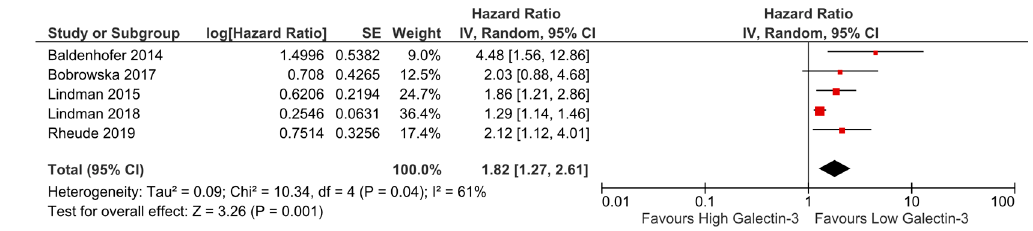
Figure 3. Forest plot of hazard and risk ratios of all-cause mortality for high vs. low levels of baseline Galectin-3 using a random-effect model. This indicates that there was 1.82 times the risk of mortality associated with the high-level group. CI: confidence interval; IV: inverse variance.